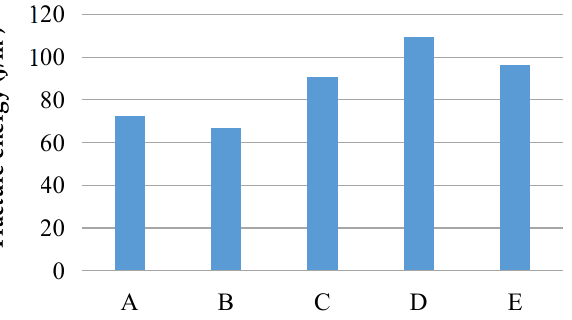
Figure 14. Fracture energy of the cement matrix with different sand particle sizes.